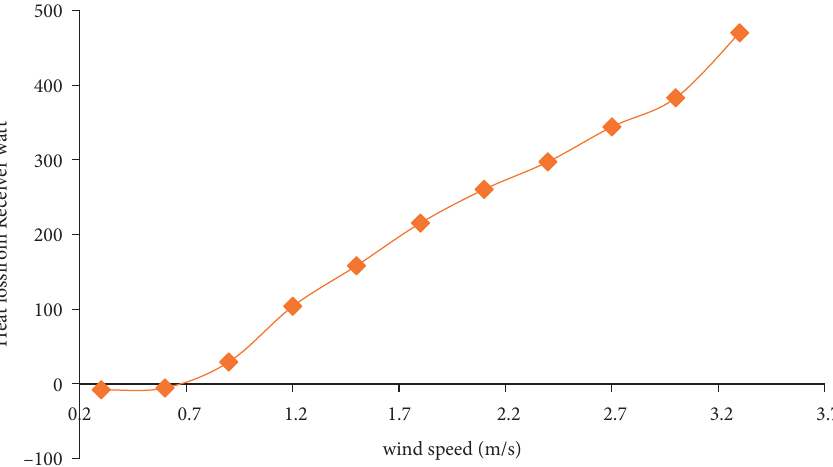
Figure 9: Heat loss from receiver for wind speeds.